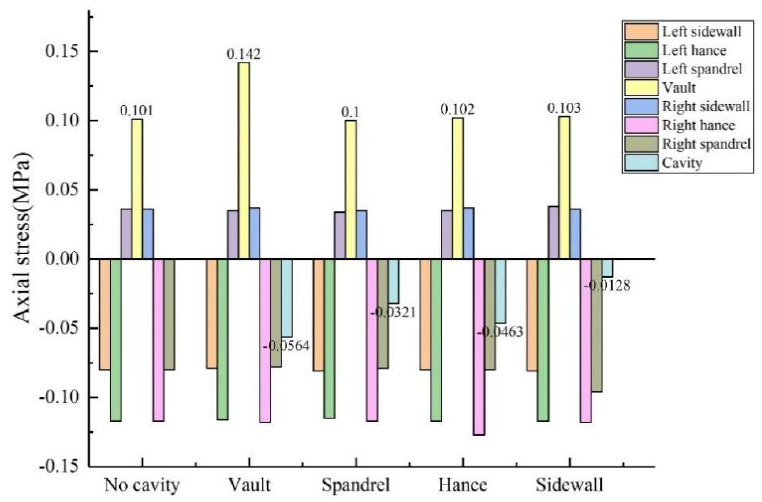
Figure 11. Variation of axial stress with void location.